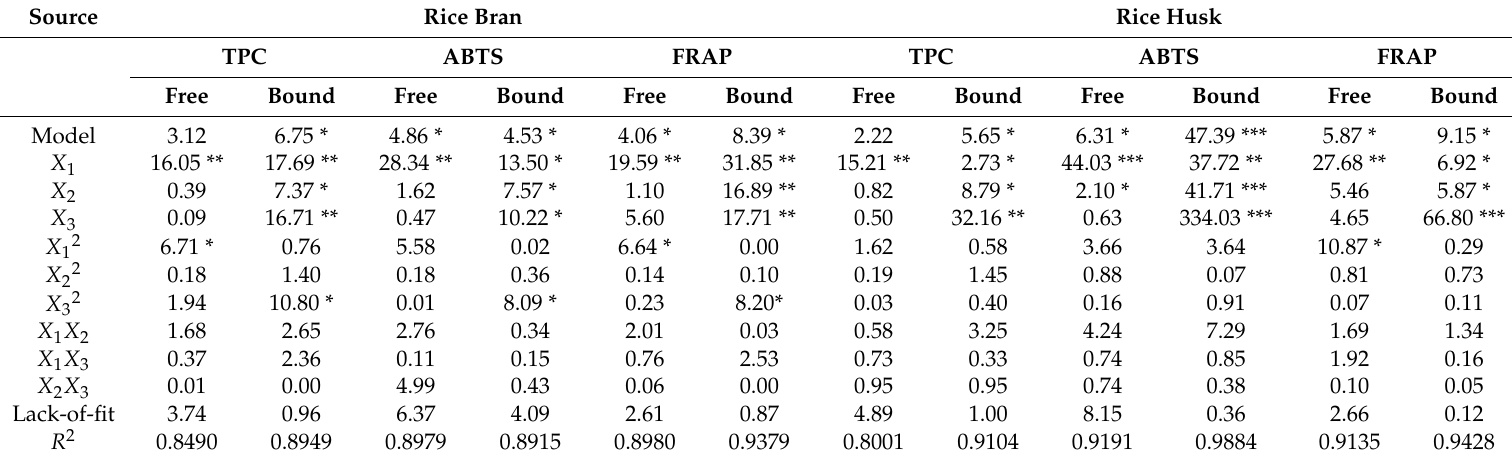
Table 2. F -values and coefficient of determination of the predicted second order polynomial models for free and bound phenolics.